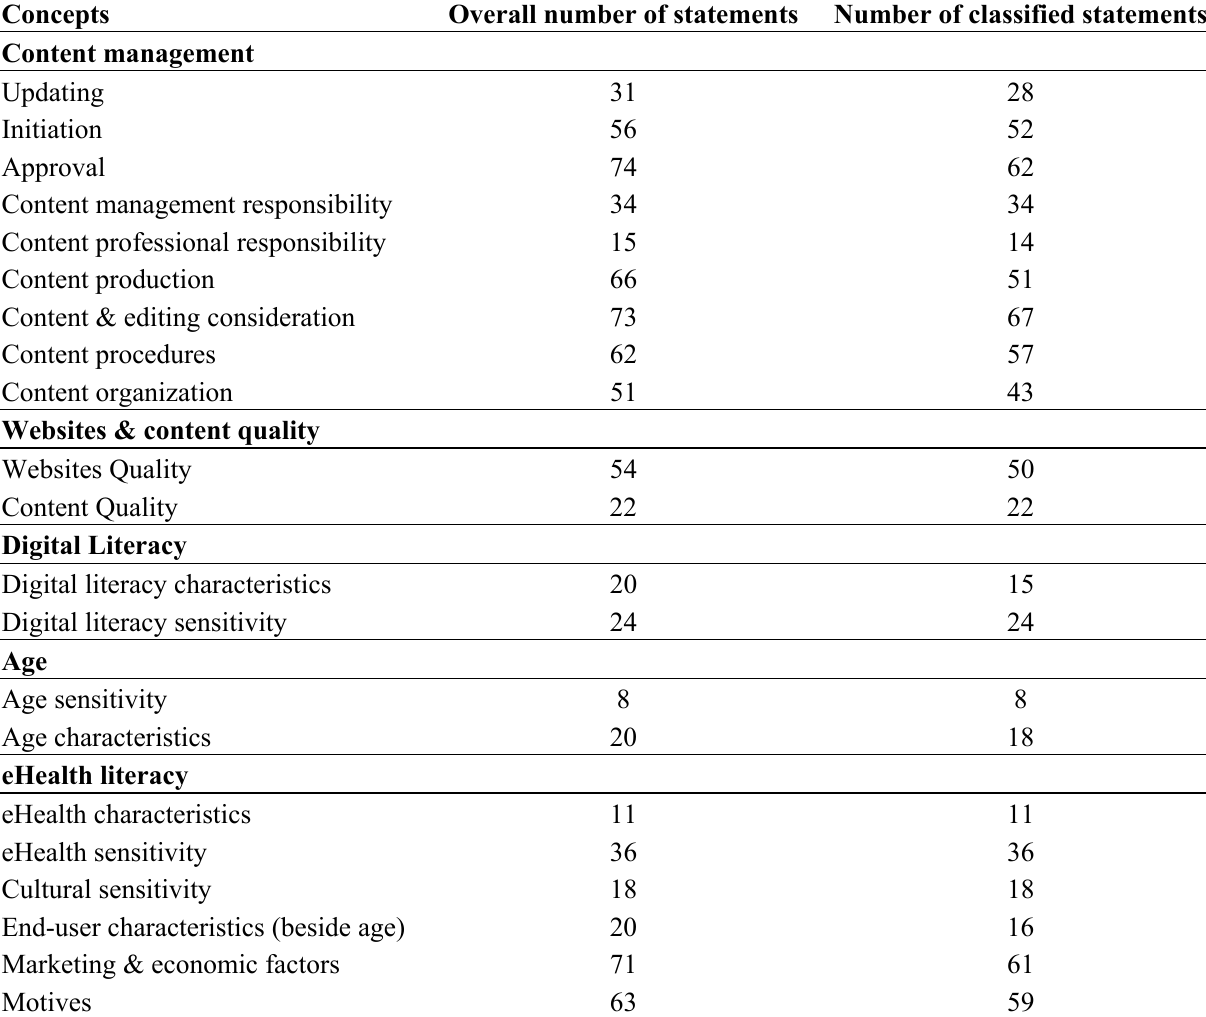
Table 2. Concepts’ frequency and attribution to further